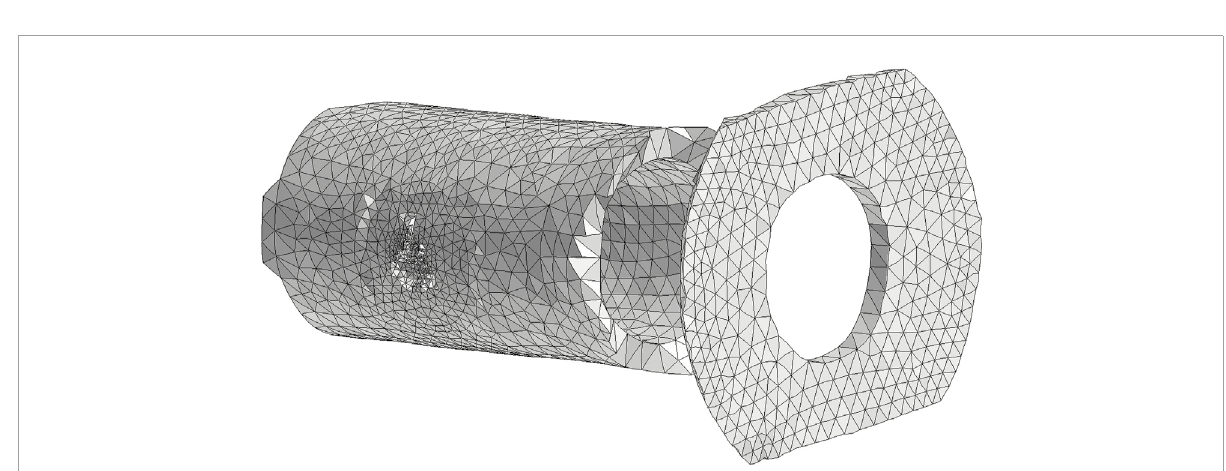
FIGURE 12 Finite element mesh restrained to Ω R ( N /card( F ) = 2 ) . Most removed elements are located around the hole.